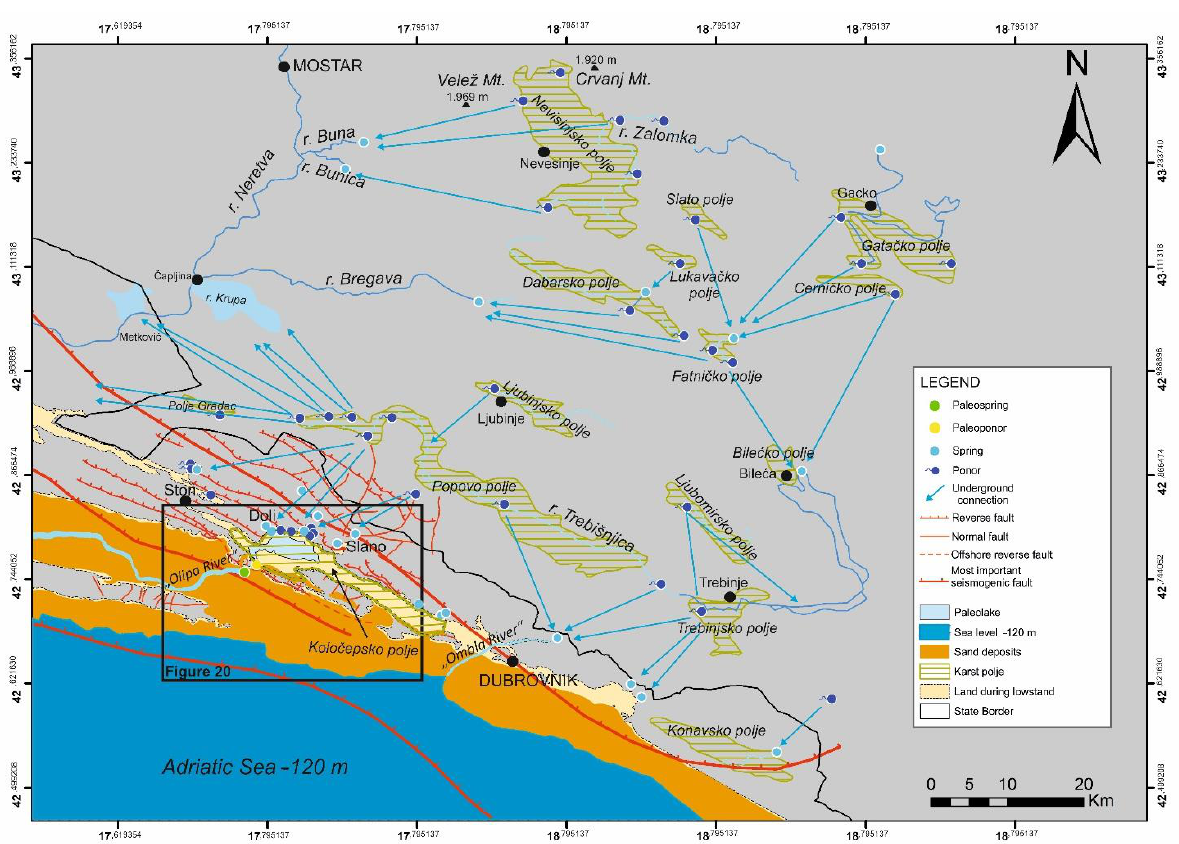
Figure 21. Wide area of Doli – Slano littoral with larger karst poljes in the hinterland. Scattered appearances of ponors and springs and their underground connection (modified from [27,28,54]) with important faults in the area [52 ]. The figure shows the area during the sea level at −120 m. The area represents the land on which aeolian sands were deposited, with a lake within the karst polje and paleo-river flowing outside of the polje. Detailed map (Figure 20) of the area with paleo spring and paleo ponor of the Olipa paleo-river with 2 possible scenarios of flow.